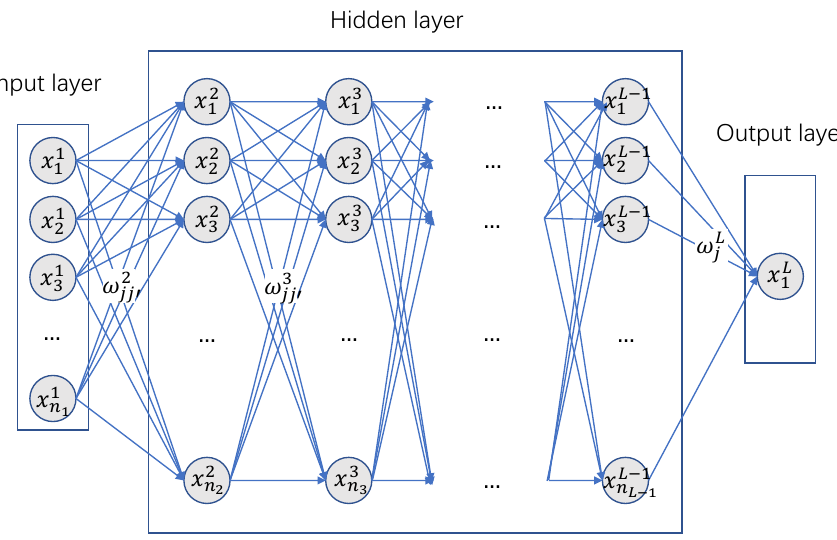
Figure 3 . The graphical representation of the